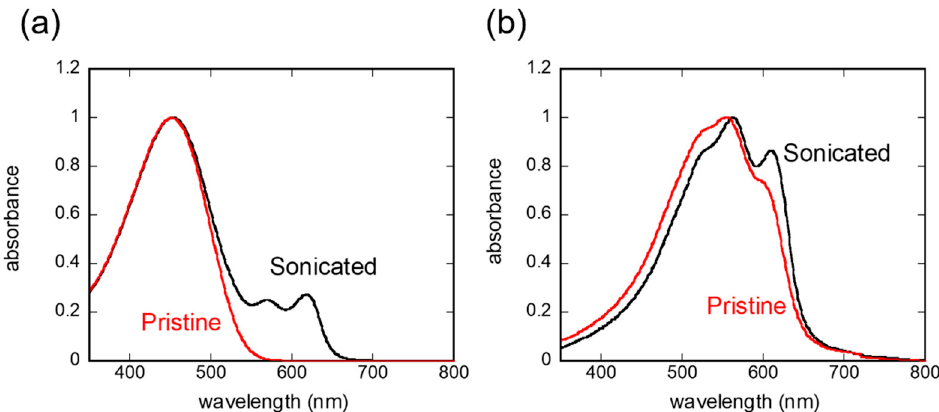
Figure 4. Comparison of optical absorbance between the pristine and the sonicated P3HT for ( a ) solution (5 mg/mL in CHCl 3 ) and ( b ) film states (90 nm).